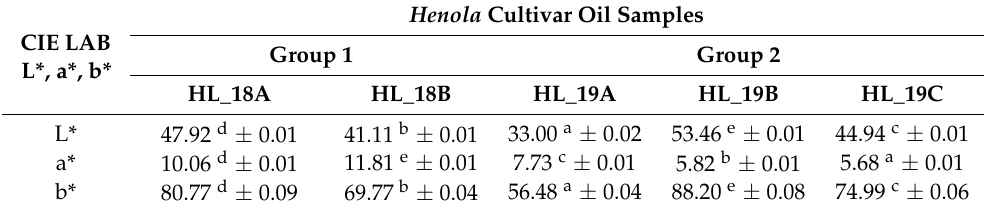
Table 1. Color determination using a spectrophotometer.